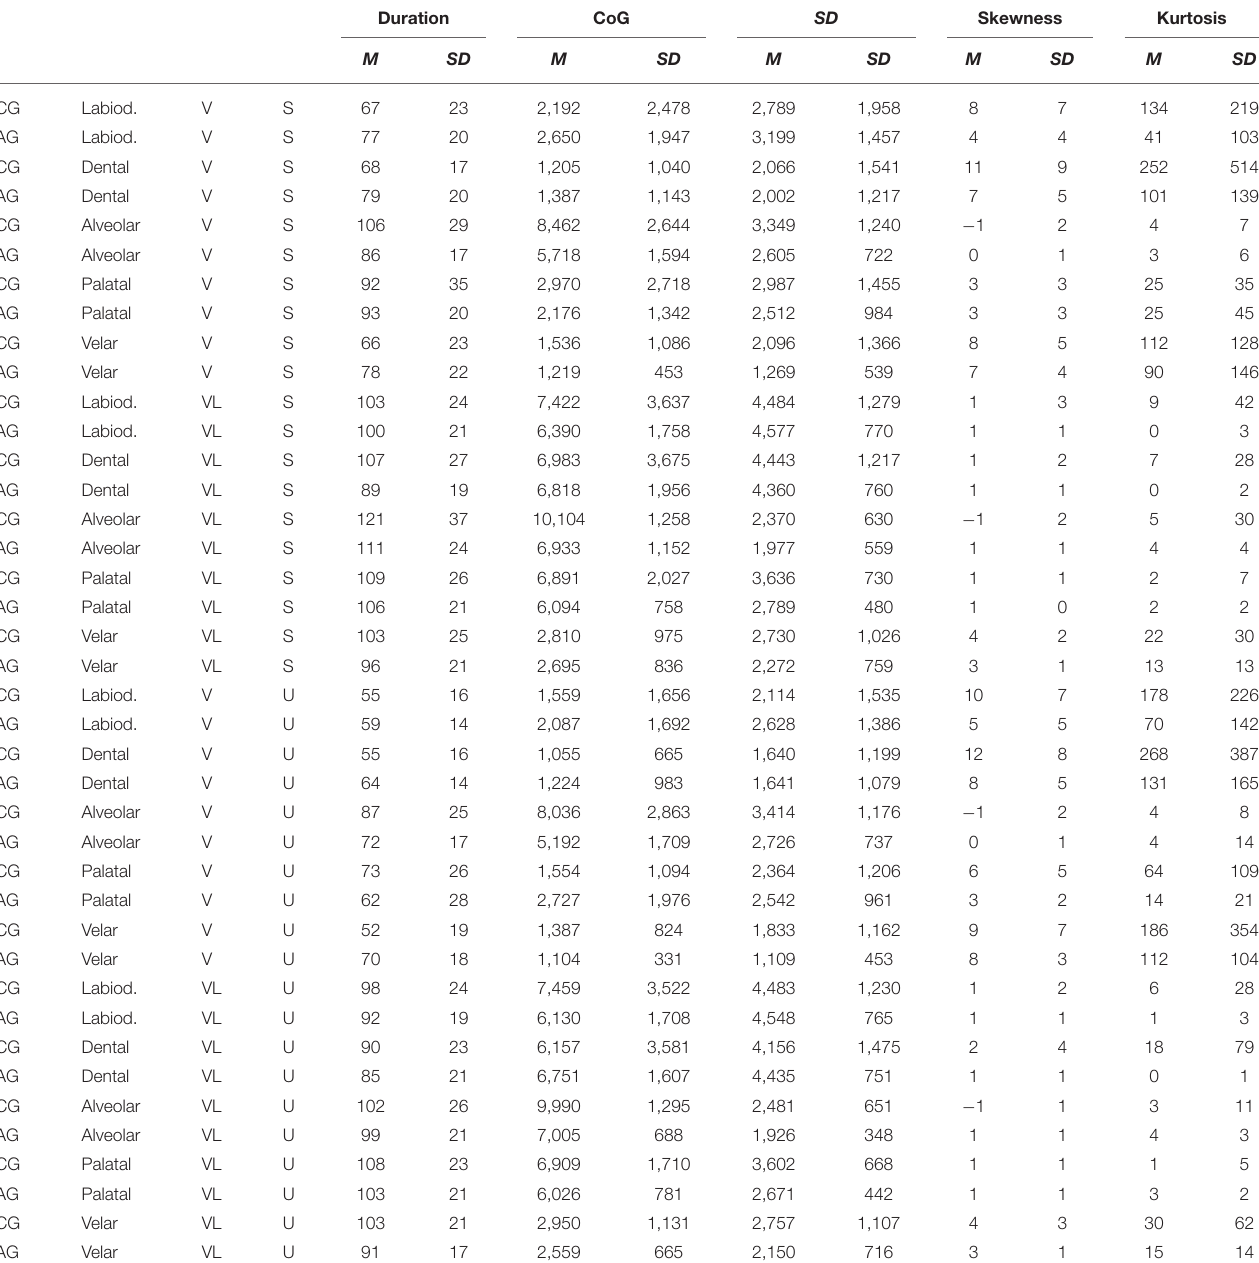
TABLE 3 | The mean and SD of duration (in ms), center of gravity (in Hz), standard deviation (in Hz), skewness, and kurtosis of Athenian Greek (AG) and Cypriot Greek (CG) fricatives articulated at Dental, Labiodental, Alveolar, Palatal, and Velar place of articulation. Duration CoG SD Skewness